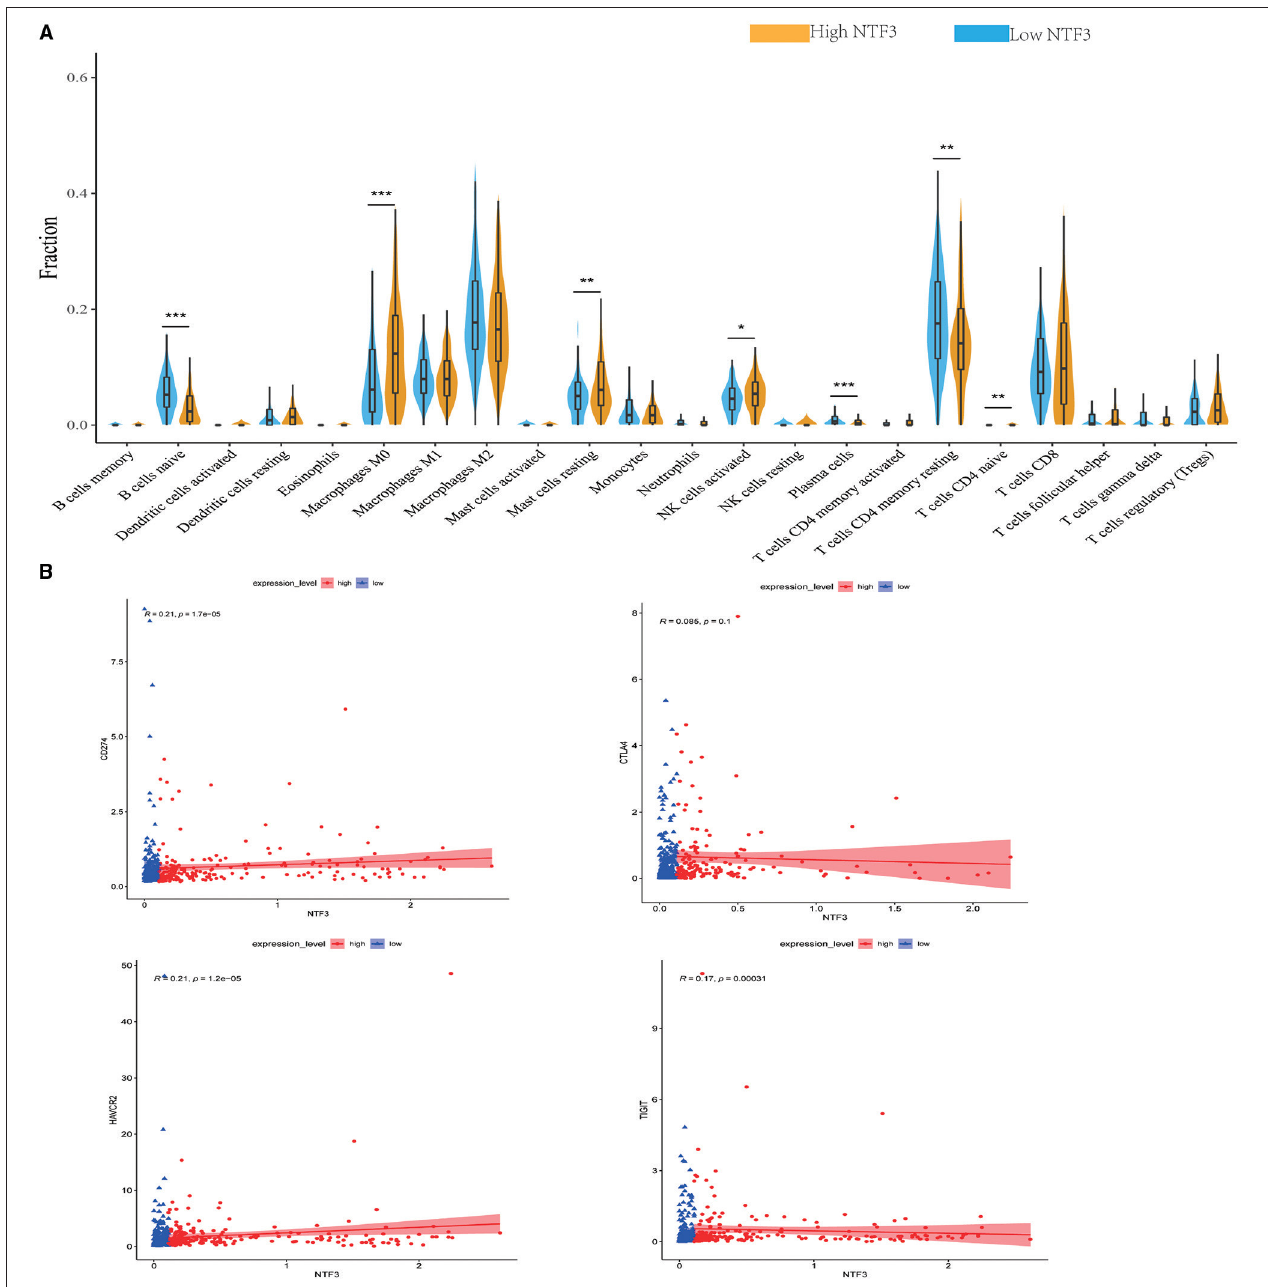
FIGURE 8 | NTF3 affects immune cell infiltration and T-cell exhaustion markers (CIBERSORT) in patients with HCC. (A) Violin diagram shows the relationship between NTF3 expression level and the tumor-infiltrating immune cells. Among them, naïve B cells, plasma cells and resting memory CD4 + T cells are significantly increased in the low NTF3 expression group. M0 macrophages, mast cells, activated NK cells and naïve CD4 + T cells are significantly decreased in the low NTF3 group. (B) NTF3 expression is positively correlated with PD-L1, TIGIT and